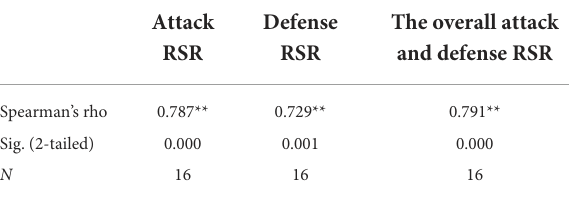
Attack Defense The overall attack RSR RSR and defense RSR